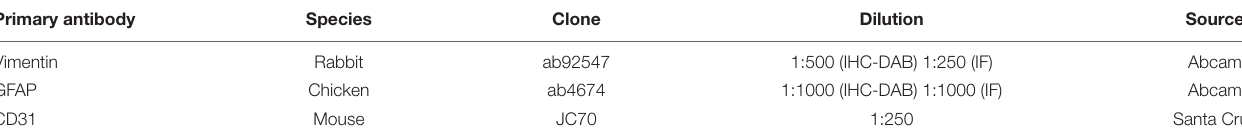
TABLE 2 | Antibodies